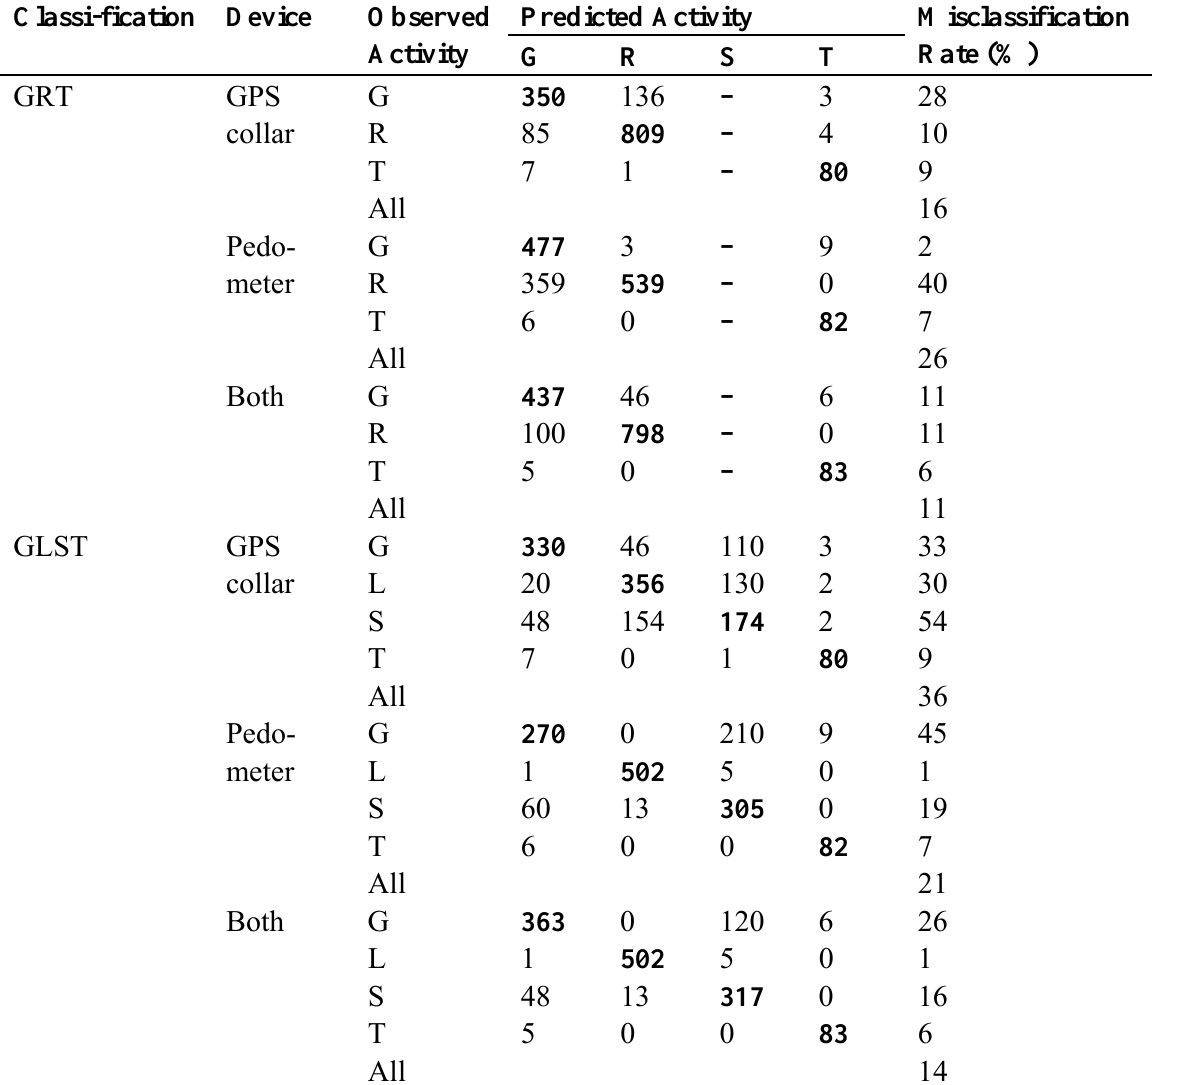
Table 1. Frequency of observed versus predicted activity and misclassification rates obtained in the inference of animal activity, classified as GRT and GLST, by discriminant analysis of results obtained from Lotek GPS collars only, IceRobotics IceTag pedometers only, and both devices together. Elements on the upper-left to lower-right diagonal (bold) are correctly classified observations. Ideally, all observations should fall on this